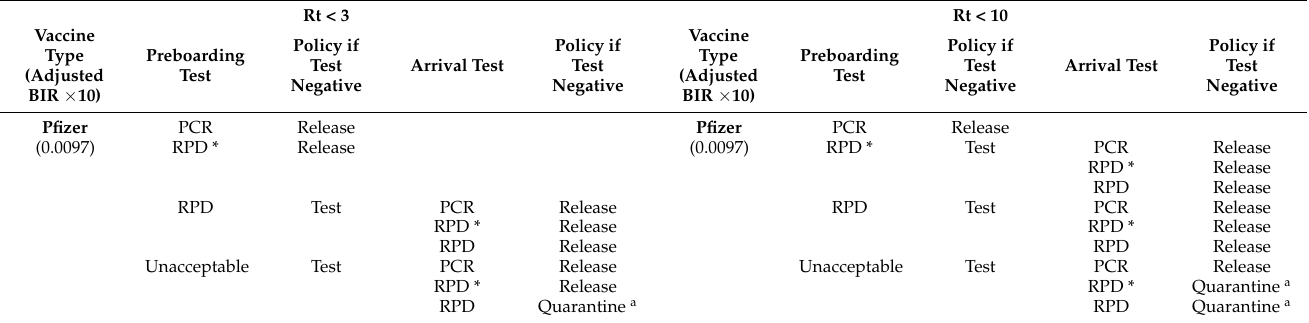
Table 2. Testing and quarantine strategies for fully vaccinated travelers (individual